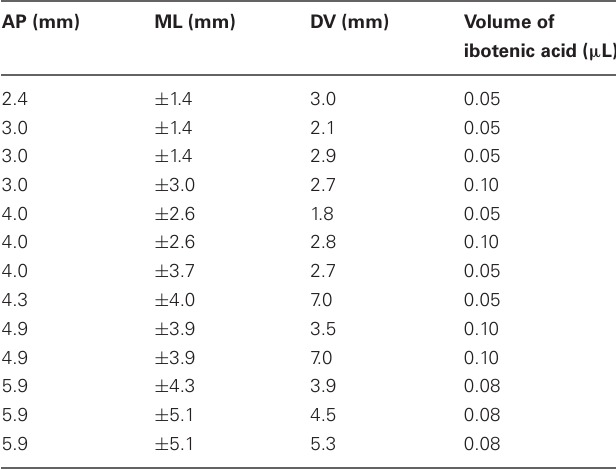
Table 1 | Coordinates for ibotenic acid infusions into the hippocampus.